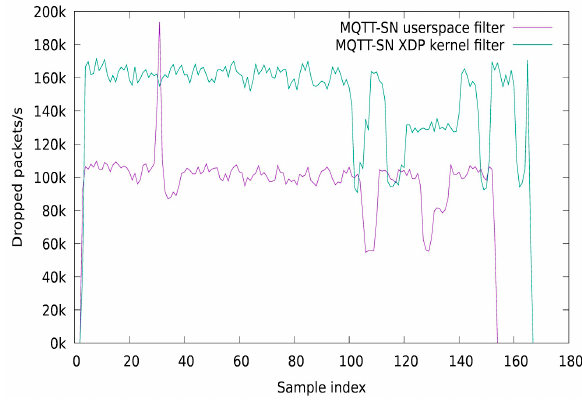
Figure 8. Drop packet rate (per second), in a DoS attack scenario.